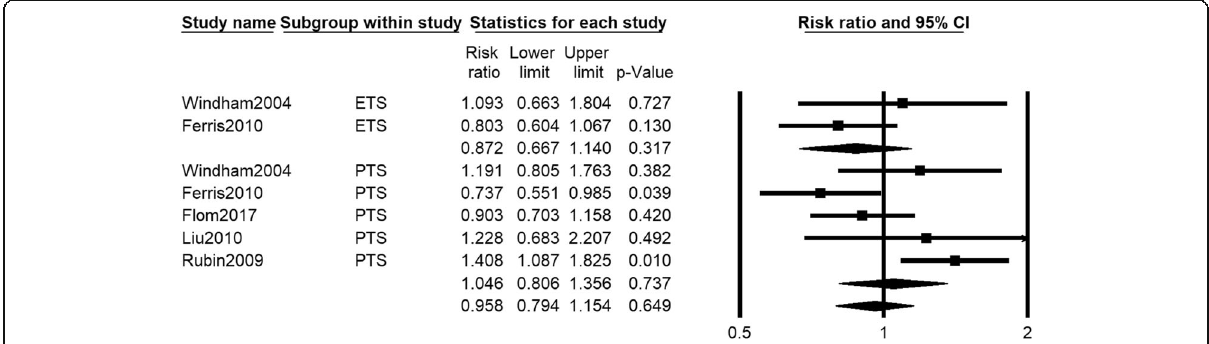
Fig. 4 Forest plot for the number of girls with early menarche between the PTS or ETS group and control group